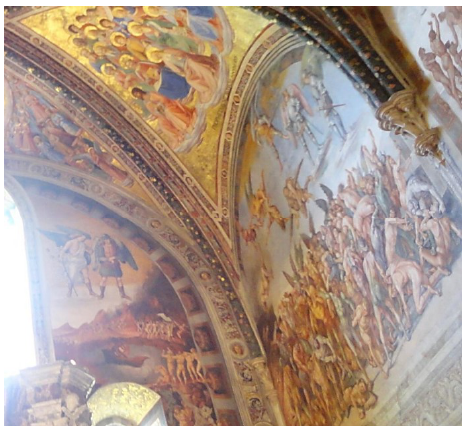
Figure 9. The San Brizio Chapel: photograph acquired with a Canon digital camera. The picture is highly illuminated due to the presence of three wide windows inside the chapel. (Photo: S. Ceccarelli). The final 3D model was built from the merging of multiple scans acquired with a very partial overlapping along the edges, in order to give reference points during the registration process, carried out by picking the same points in the two textures to register, as shown in Figure 10.